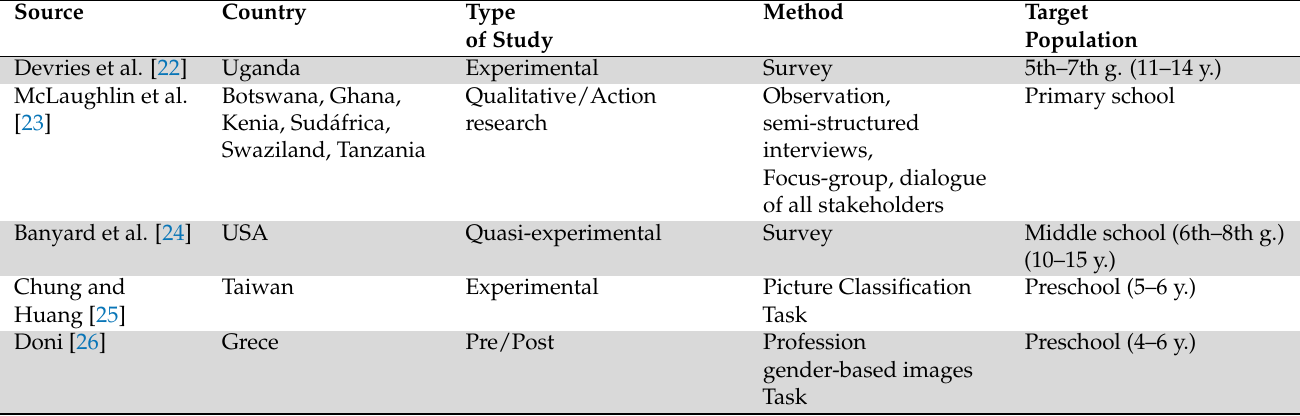
Table 2. Overview of the studies’ main